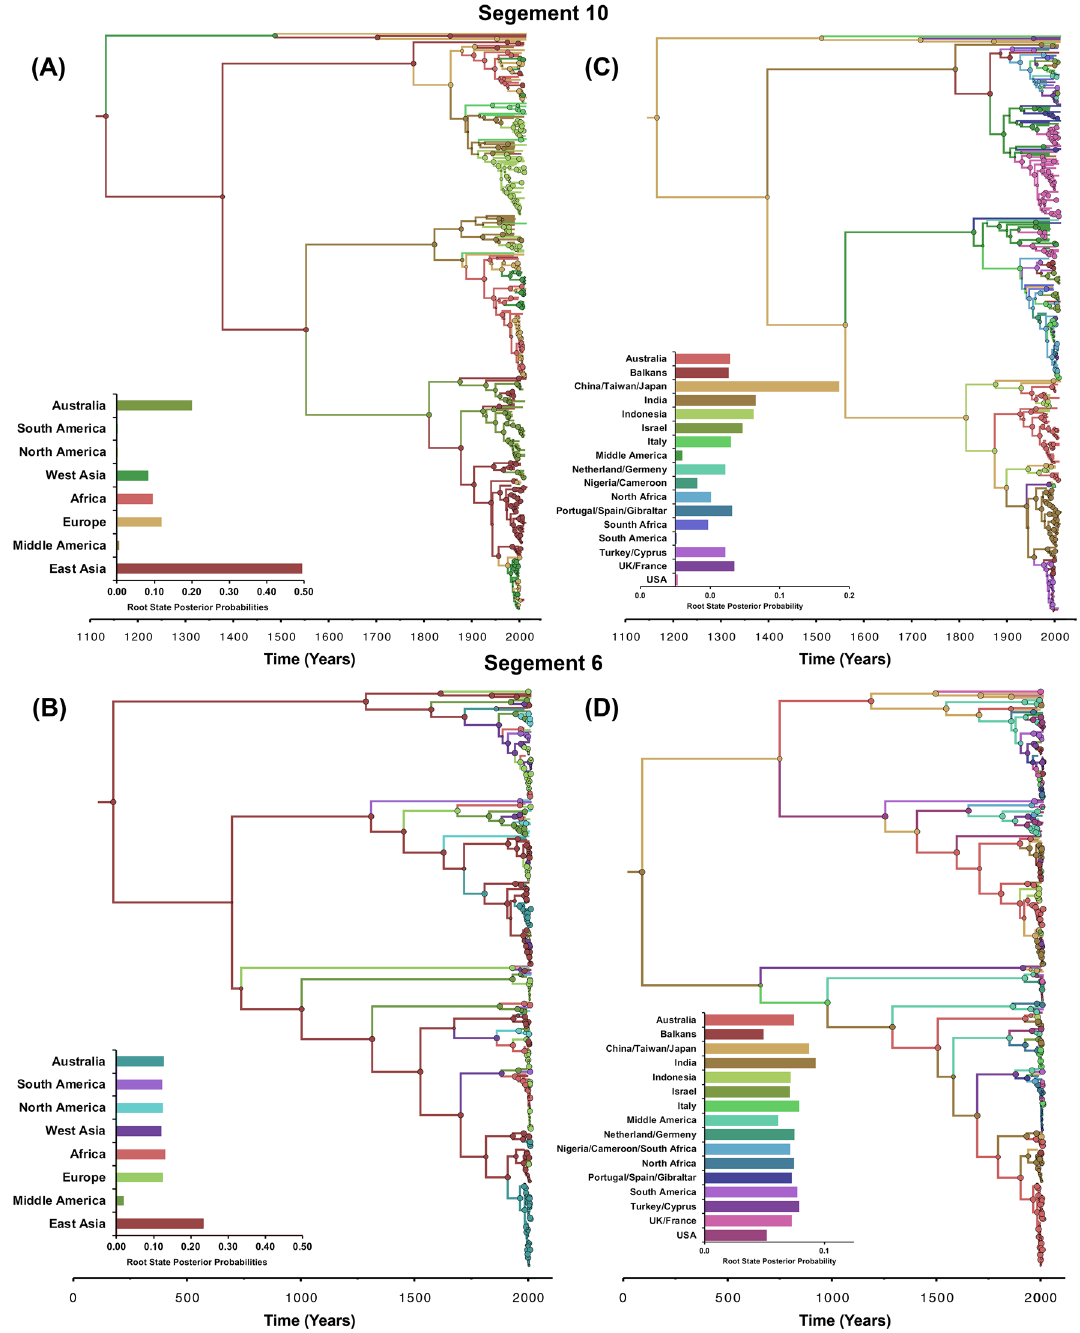
Figure 2. Maximum clade credibility (MCC) phylogeny of segments 10 and 6 sequences of Bluetongue virus between 1958 and 2016. The trees are inferred from the symmetric phylogeographic model with reversible transitions. Colour of the branches represents the most probable location state of their descendent nodes. The color-coding corresponds to the upper left bar chart which represents the root location state posterior probabilities for each country. Circle sizes are proportional to the posterior node support. ( A , B ) MCC tree inferred from continental level phylogeographic analysis ( C , D ) MCC tree inferred from country level phylogeographic analysis. ( A , C ) indicate segment 10. ( B , D ) indicate segment